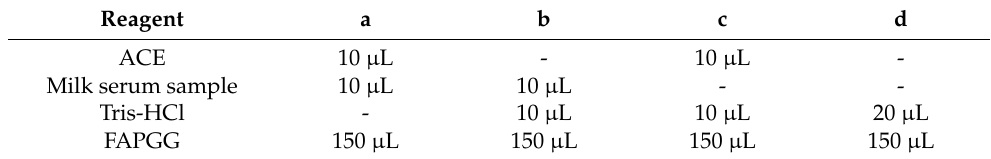
Table 1. Determination of the ACE inhibition